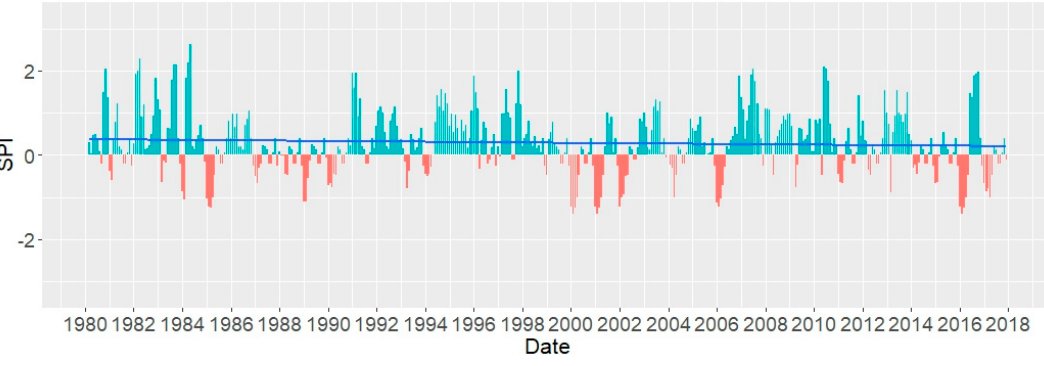
Figure 7. Three-month SPI of the Pasni station.